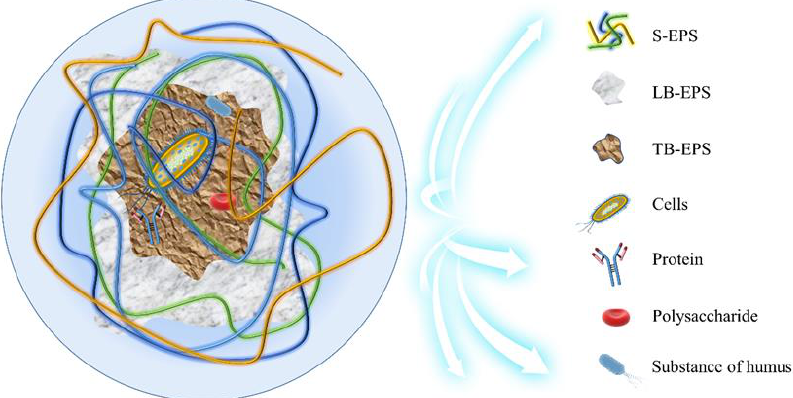
Figure 4. Schematic diagram of the EPS